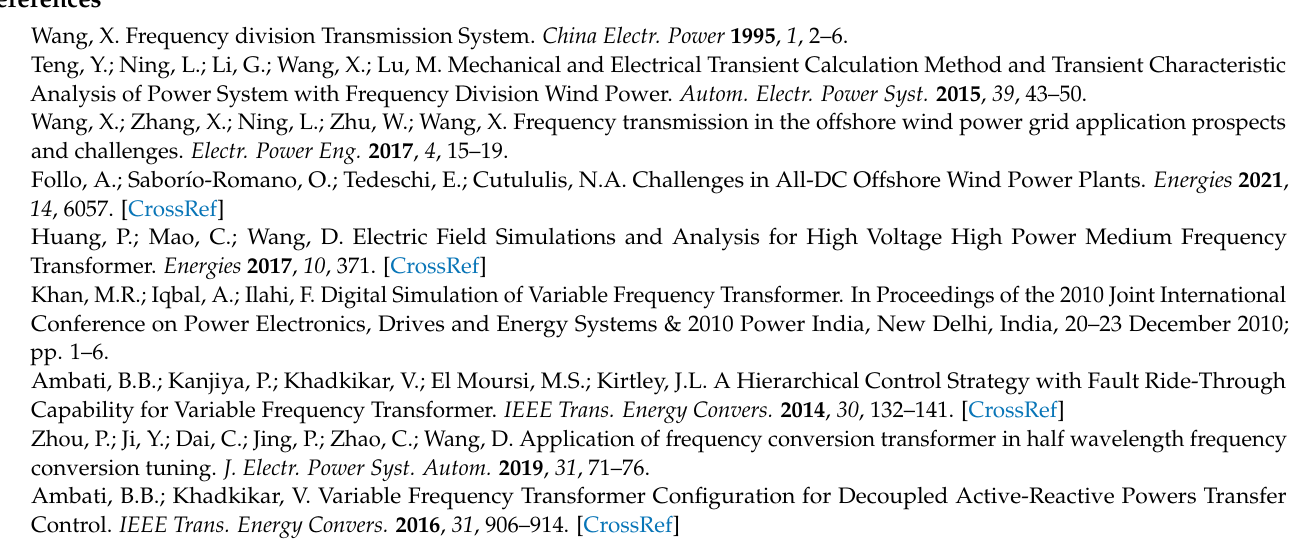
Figure 15. Variation trend of frame flux harmonic content.